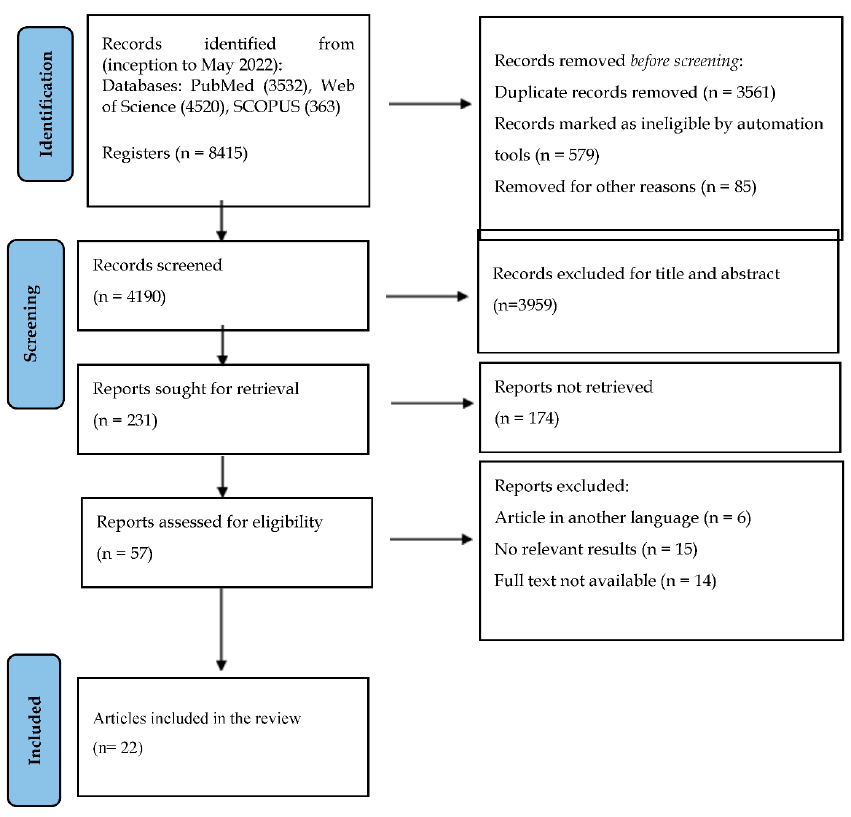
Figure A1. Flow chart.